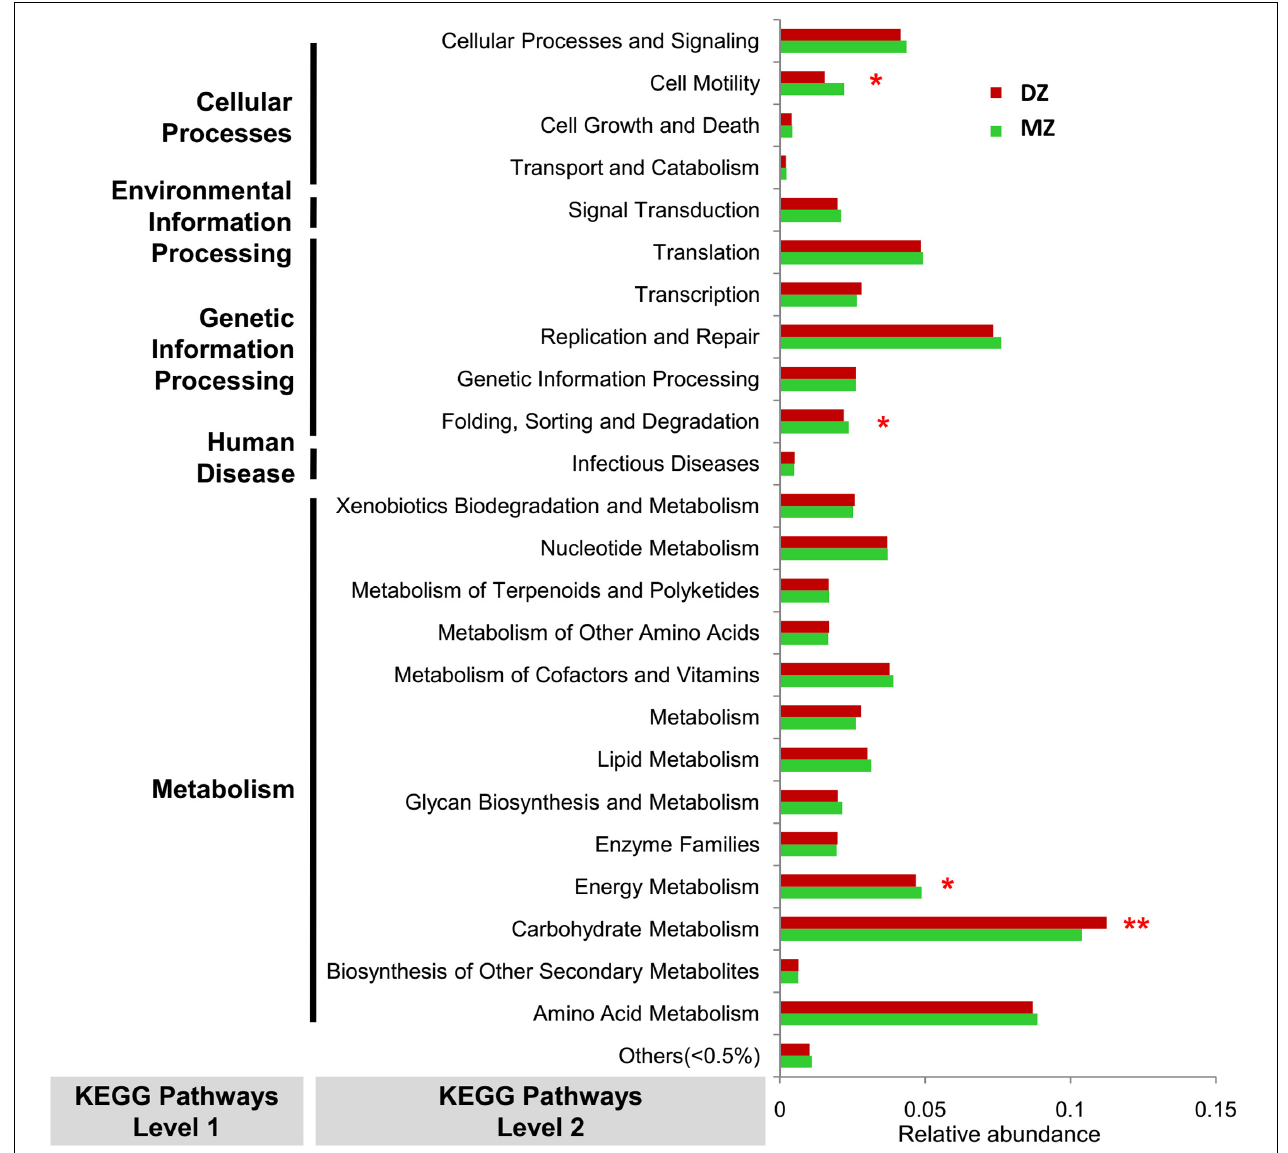
FIGURE 6 | Variation in abundances of predicted KEGG pathways between DZ and MZ. * p < 0.05, ** p <